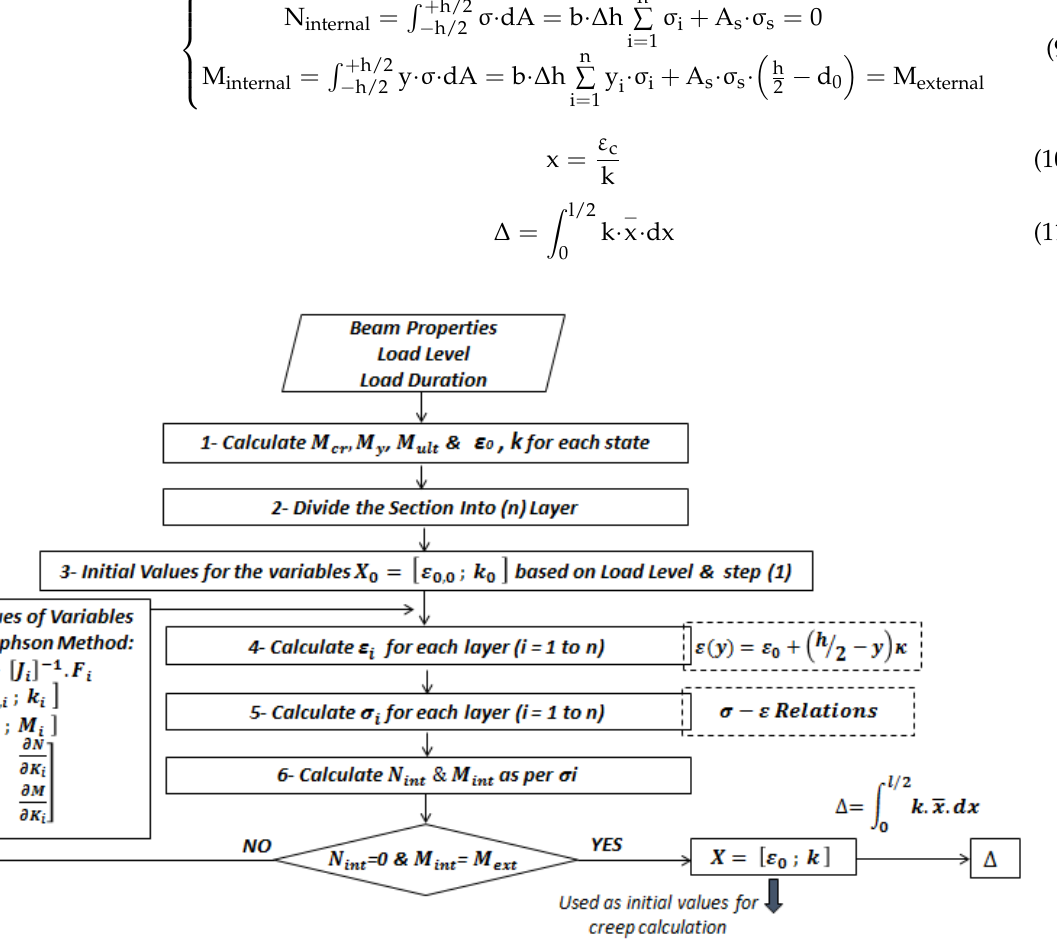
Figure 6. P-Δ diagram comparison: Experiments vs. Present Work; ( a ) Ignjatovic et al. [19]; ( b ) Seara- Paz [20]. The results of a comparison between numerical and experimental results for additional beams obtained from the literature for the instantaneous behavior [10–12] are